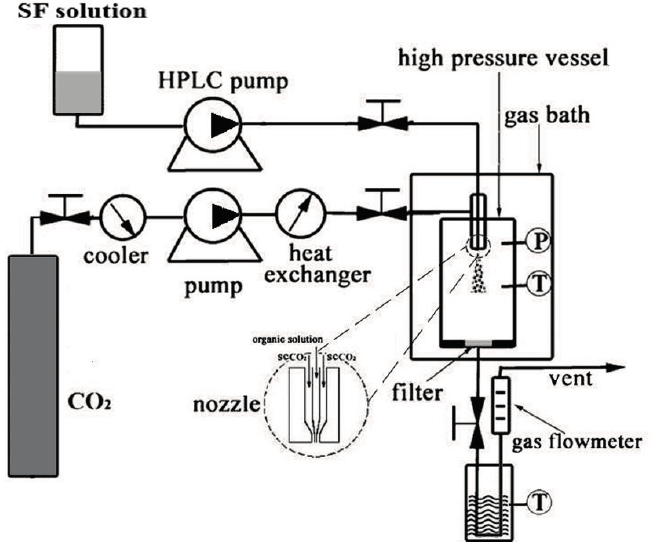
Figure 3. Schematic diagram of the SEDS process for preparing SF nanoparticles.